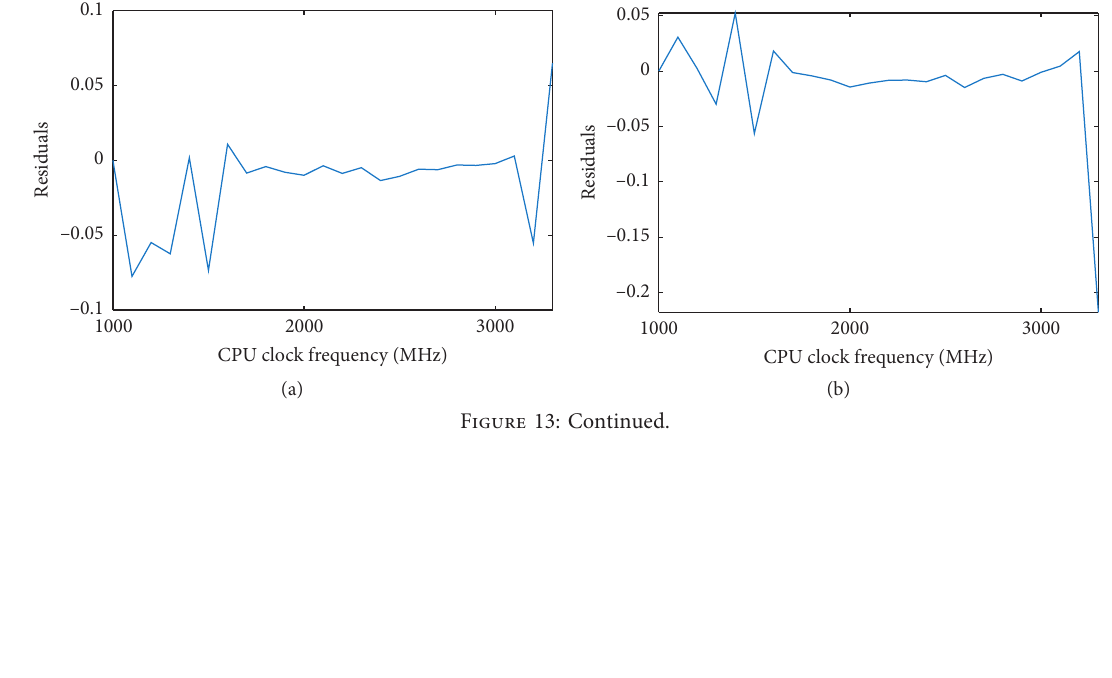
Figure 12: System 1: residuals for the predicted lates for f (d) 20MHz